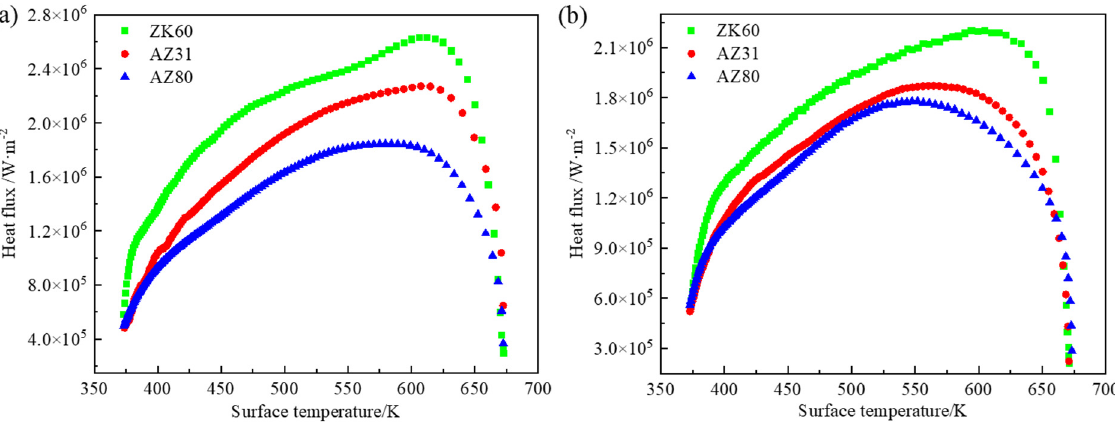
Figure 7. Effect of alloy type on heat flux in the impingement zone ( a ) and the free-falling zone ( b ).